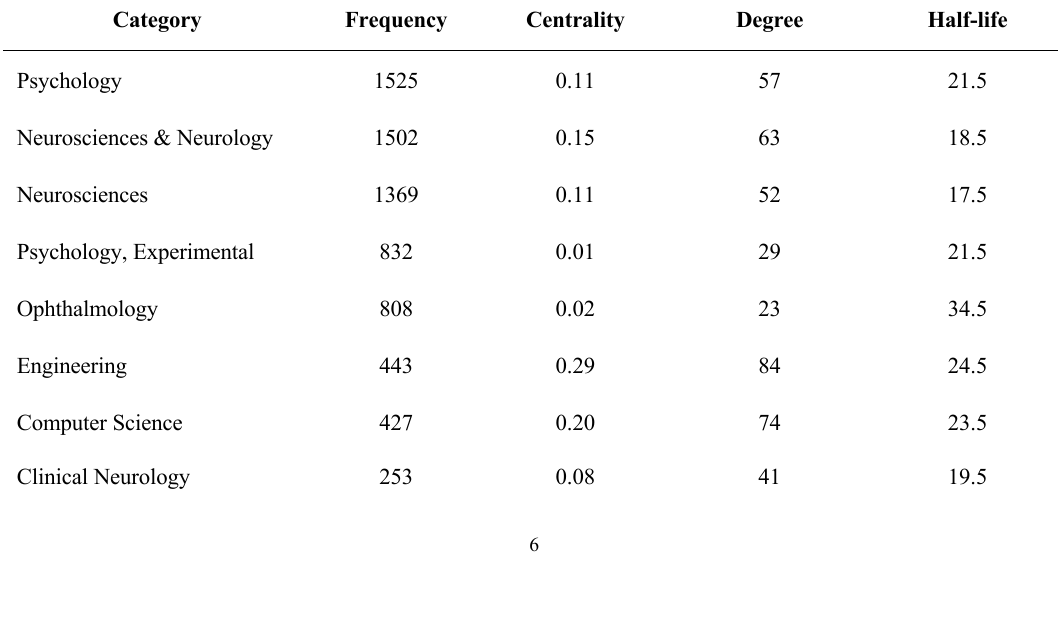
Table 3. Top 10 research areas with the highest number of